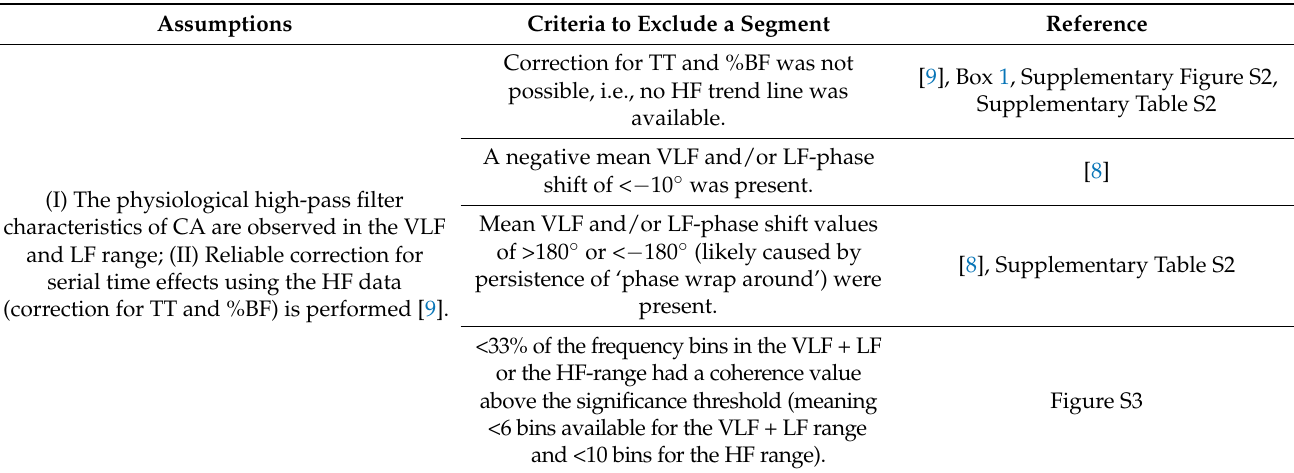
Table 1. Transfer function analysis phase plot criteria for segment selection. A detailed rationale for the automated ten-minute TFA phase plot data segment selection (segment) is provided in Supplementary File